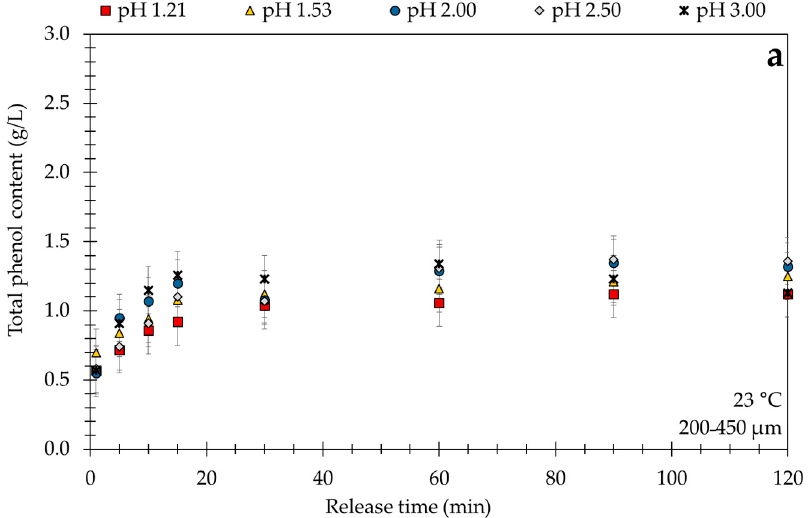
Table 1. Red vine leaves properties and extraction conditions.